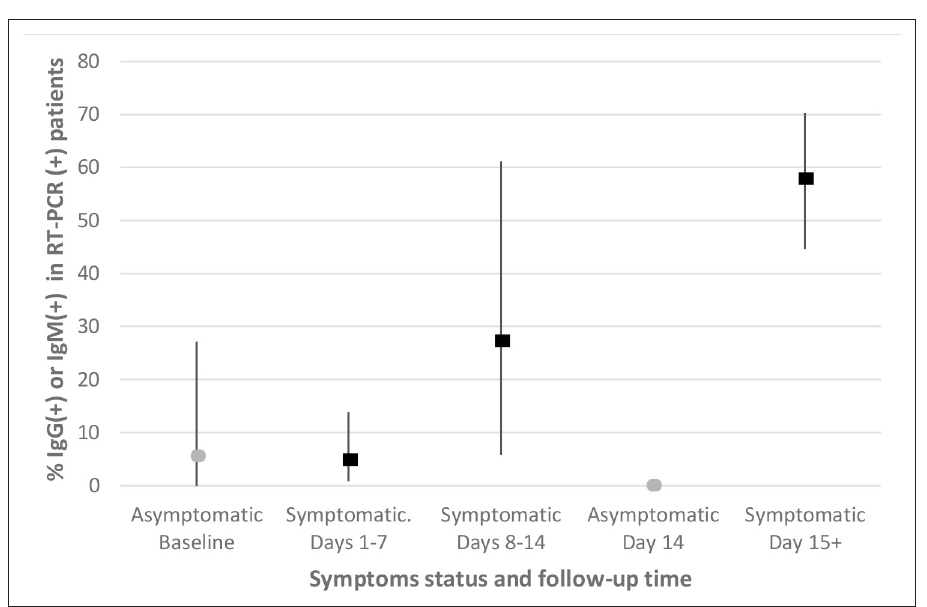
Figure 1 Positive rate (%) of IgM or IgG in symptomatic and asymptomatic patients with positive RT- PCR over time. RT- PCR = reverse transcriptase- polymerase chain